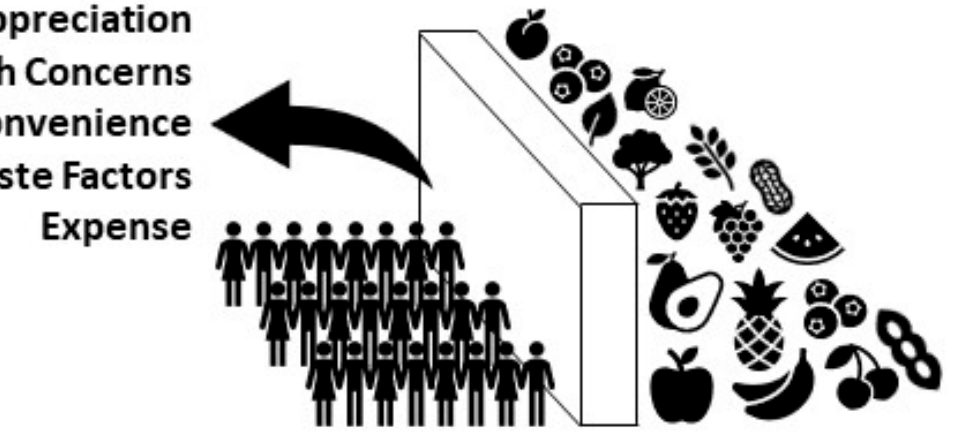
Figure 2. The main barriers to widespread adoption of plant-based dietary patterns.